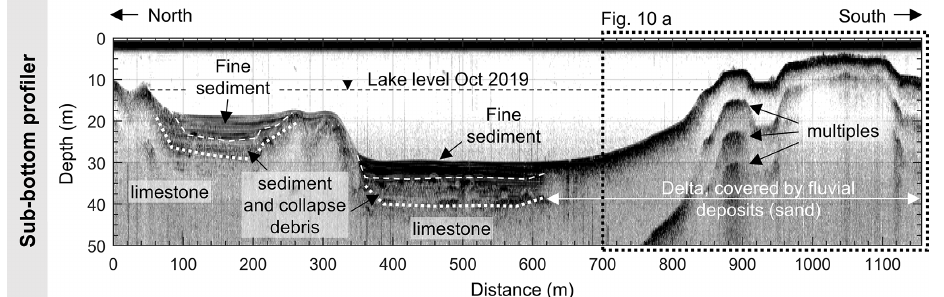
Figure 9. Long N–S-oriented sub-bottom profiler section crossing the entirety of Lake Tzibaná (Profile 5). The last approx. 450m roughly coincides with the TEM section along Profile 6 in Fig. 10a (indicated by the dotted rectangle). The white dashed lines highlight the main reflector below the lake floor, which is interpreted as the lower limit of a fine-grained sediment layer. The white dotted lines enclose the zone of diffuse reflectivity associated with the collapsed, sediment-filled limestone. The black dashed line indicates the approximate lake level during the second field season in October 2019. The last 500m of the profile correspond to the delta of the Nahá river, where a high reflectivity of the sand-covered lake floor results in the occurrence of strong multiples in the